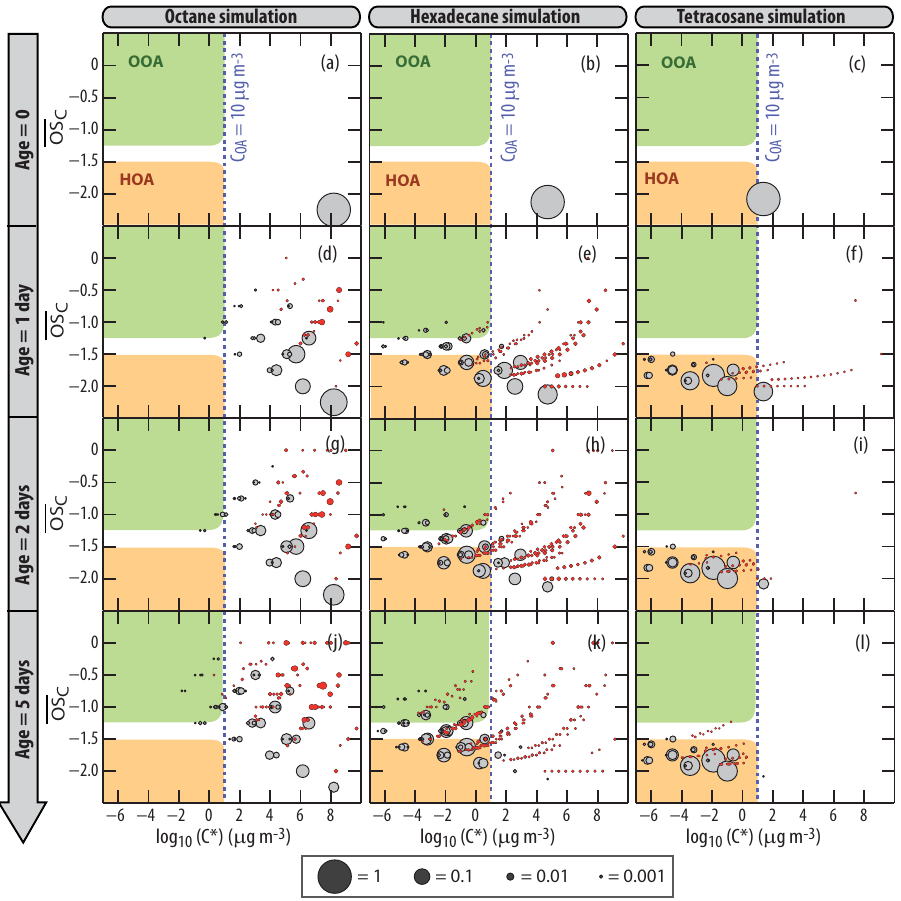
Fig. 6. Volatility and mean carbon oxidation state of the species produced during the oxidation of octane (1st column), hexadecane (2nd column) and tetracosane (3rd column) as a function of aging time. Contribution of a species to the carbon budget is proportional to the volume of the bubble. Position isomers having identical volatility and oxidation state are lumped into the same bubble. Grey bubbles denote species having the carbon skeleton of the parent hydrocarbon. Red bubbles denote species with less carbon atoms than the parent compound. The blue dotted lines indicate the organic aerosol concentration C OA prescribed for the simulation.